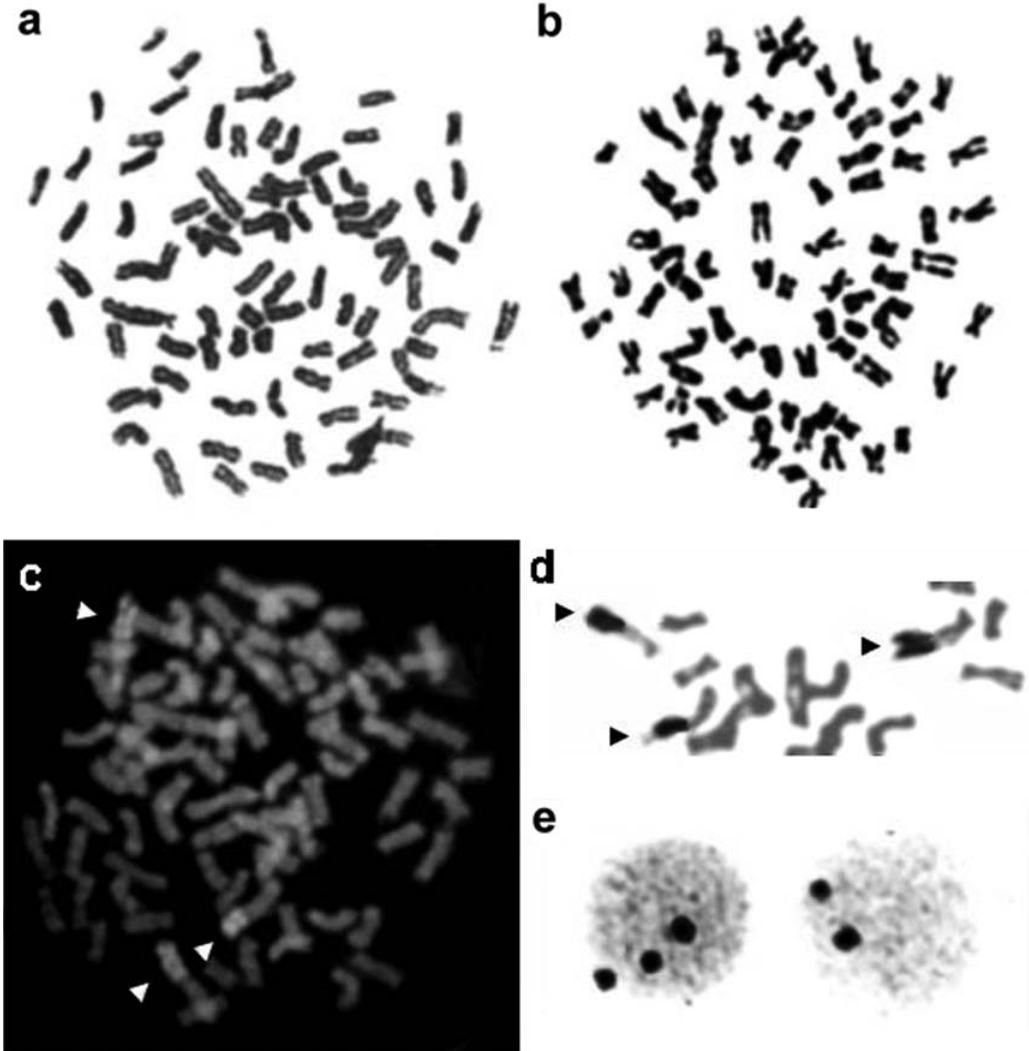
Figure 1 - (a-c) Metaphases of a triploid male L . cf. elongatus . (a-b) Giemsa staining. (c) Mithramycin staining. Arrows indicate the Z chromosomes. (d) Ag-stained partial diploid metaphase with two Ag-NOR bearing chromosomes. (e) Ag-stained nucleoli in the triploid